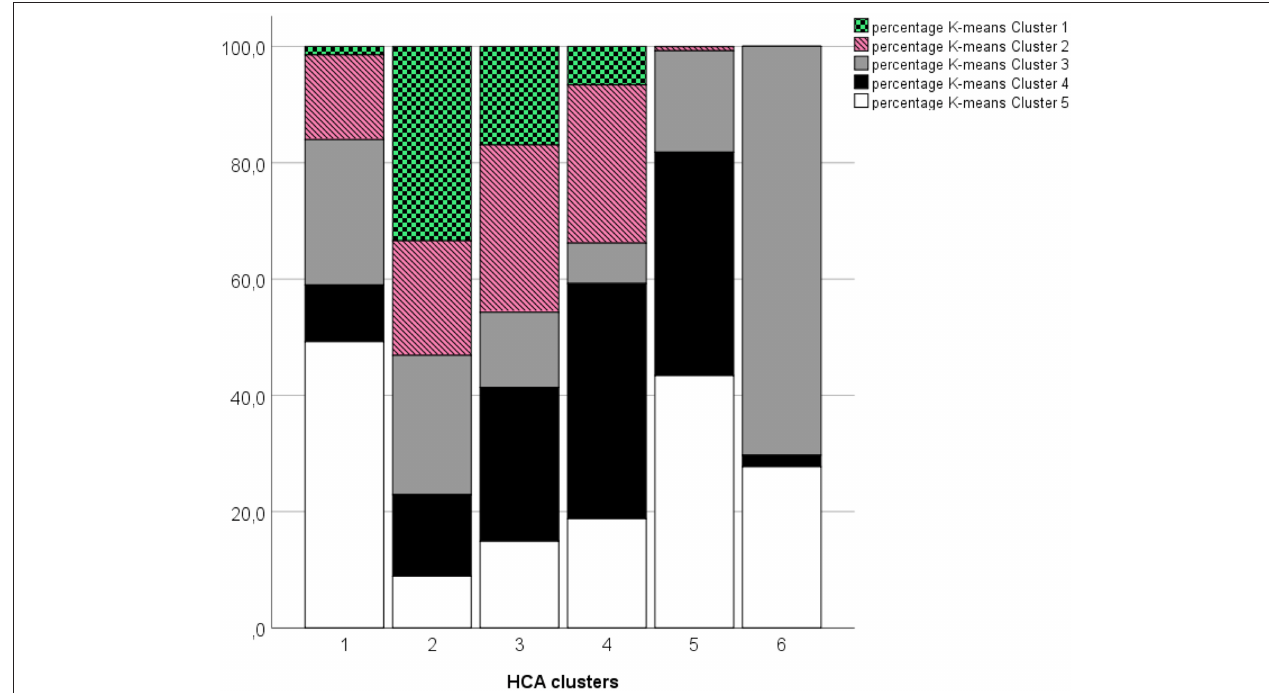
FIGURE 8 | HCA analysis aggregated by stations over the 10-year time series: each bar represents a cluster identified through HCA and colors represent the percentage of K-means Clusters present on each cluster. The HCA clusters of highest interest are 1, 4, and 5 which include the stations where the most favorable meteo-climatic conditions (i.e., K-means cluster 4 and 5) are dominant.